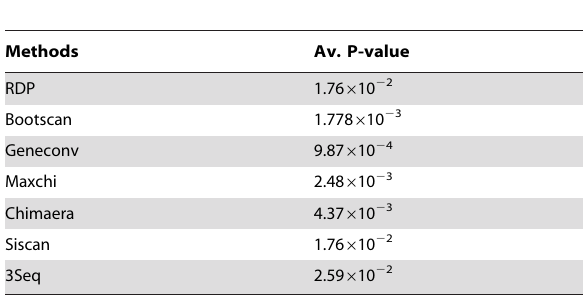
Table 1. Recombination confirmation table of different recombination analysis methods.